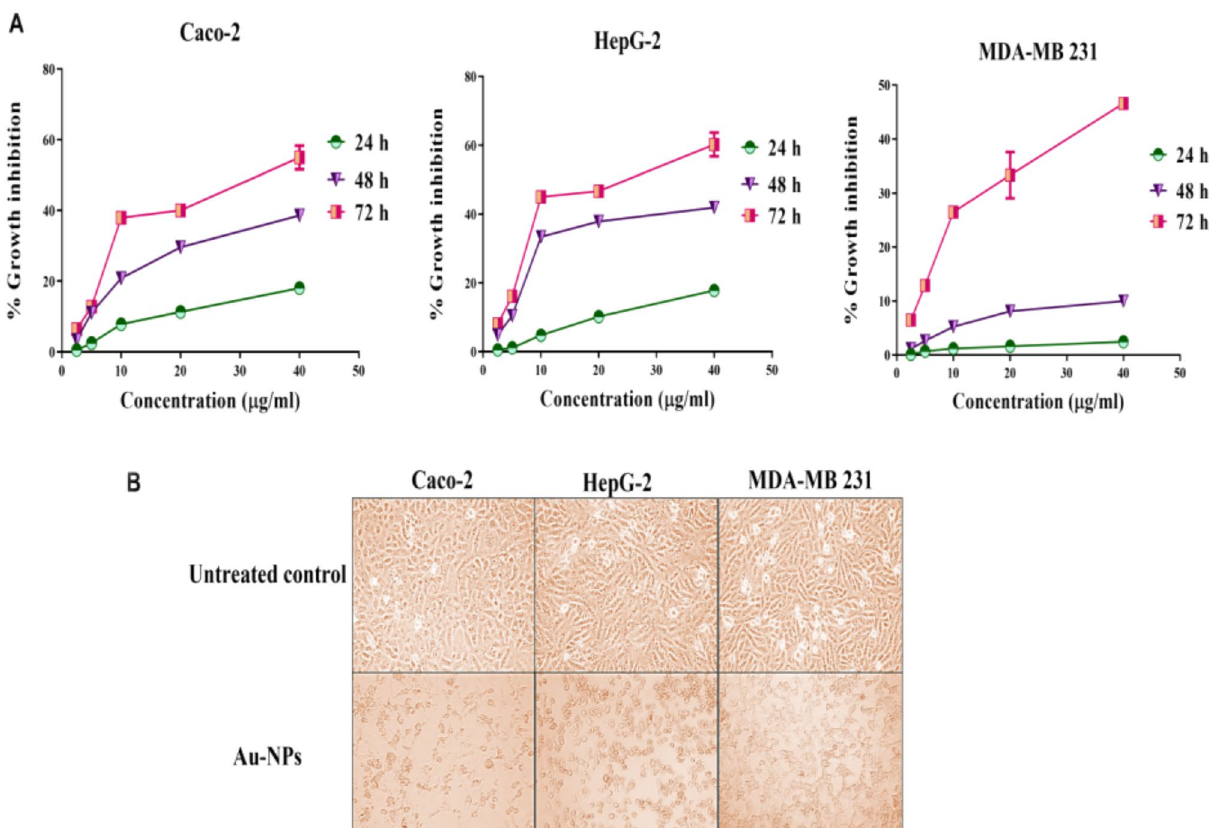
Figure 3. Cytotoxicity of the ultra-small Au-NPs on human cancer cells against human cancer cell lines (Caco- 2, HepG-2 and MDA-MB 231). ( A ) The percentage of growth inhibition of each cancer cell line after 24 h, 48 h, and 72 h incubation. ( B ) Morphological alterations of Au NPs-treated cancer cells in comparison to the untreated control cells (Magnification × 200). All data are expressed as mean ±